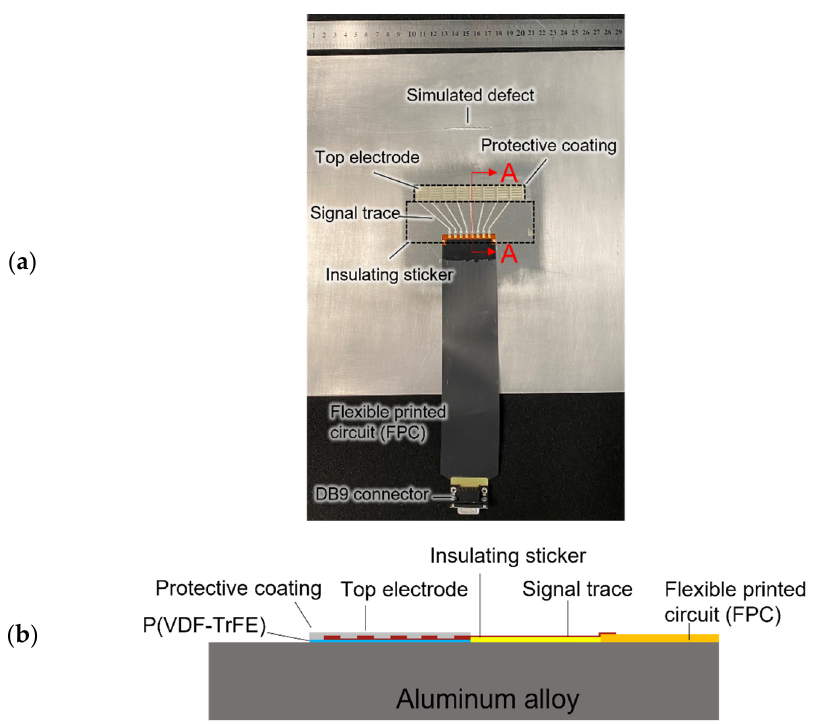
Figure 2. Aluminum alloy plate with a linear direct-write transducer (DWT) array comprising eight transducers: ( a ) photo of the test coupon; and ( b ) sectional view A-A showing layers of the DWT design.